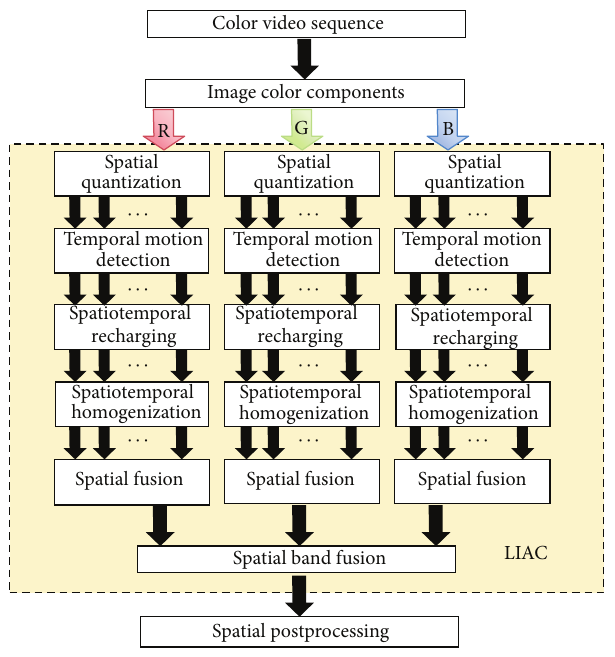
Figure 1: LIAC architecture for colour video sequences (for RGB in this